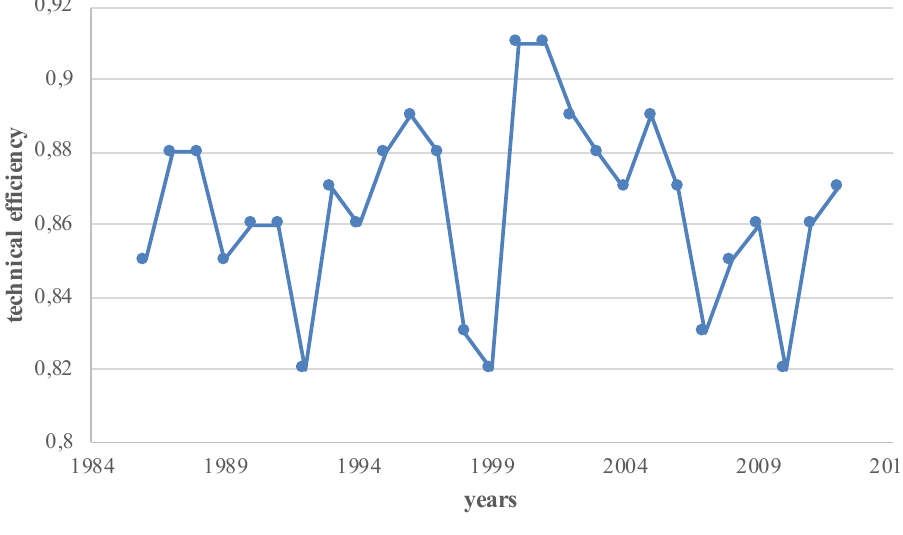
Figure 2. The average level of output-increasing technical efficiency in EU-12, 1986-2012.